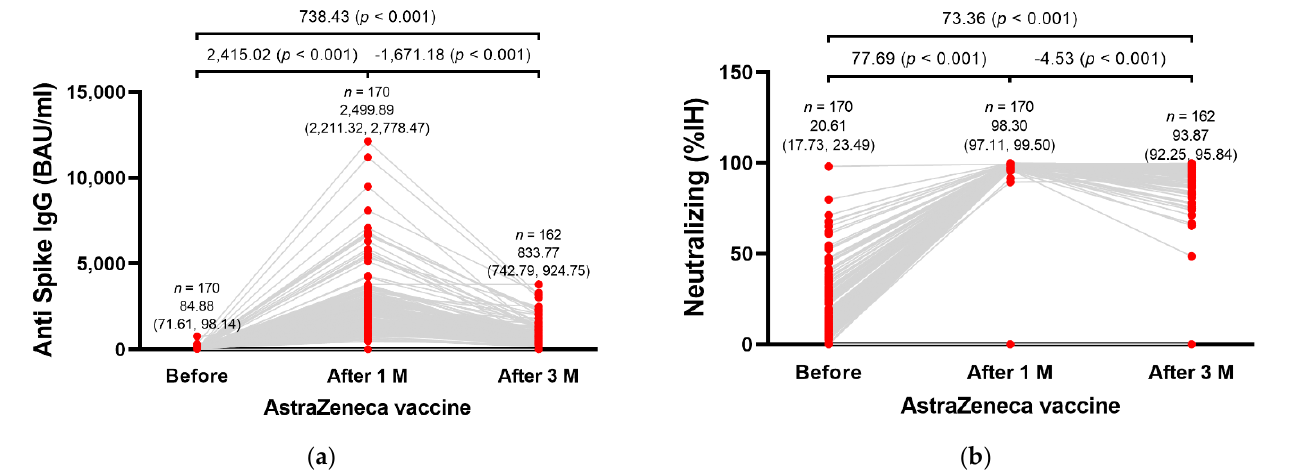
Figure 1. Humoral immunity profile in 170 participants after being vaccinated with ChAdOx1